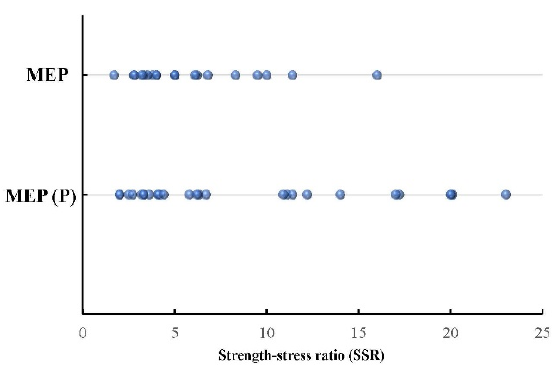
Figure 21. The distribution of excavation procedures based on SSR.